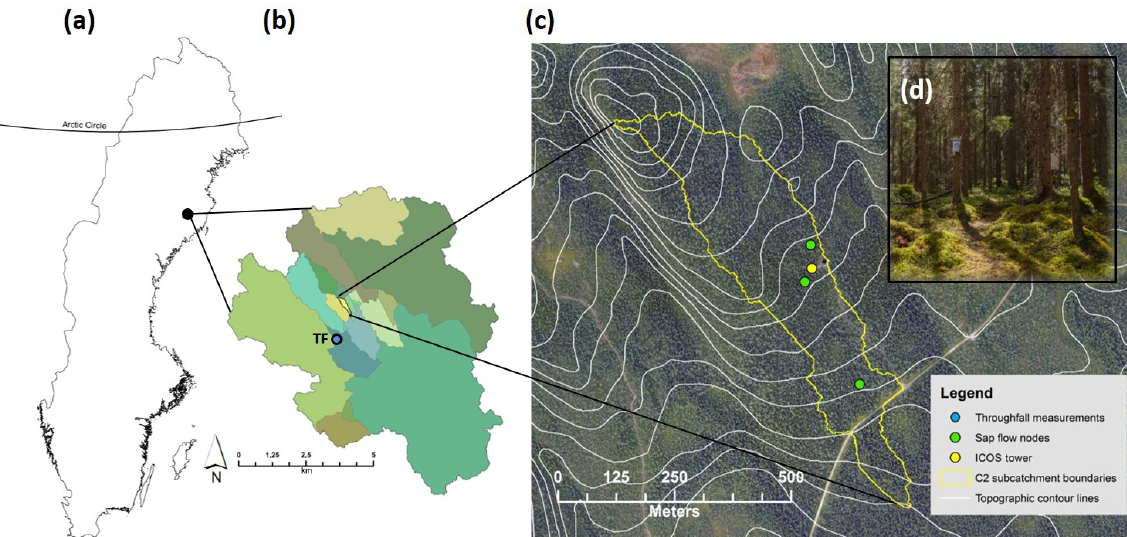
Figure 1. Location of the study area in northern Sweden. (a) The outline of Sweden with the location of the Arctic Circle for reference. (b) The boundary of the 68km 2 Krycklan catchment with various subcatchments in different colors; C2 subcatchment in yellow. Throughfall (TF) measurements were made ca. 1km from the C2 subcatchment and are shown on this map (blue circle). (c) High-resolution aerial photograph with 5m contour intervals (white line) and the C2 subcatchment boundary (yellow line). Sap flow measurements were made at three nodes (green circles) and all environmental and eddy-covariance data were taken from the ICOS tower (yellow circle). (d) Picture of the forest stand with understory vegetation that is characteristic of the C2